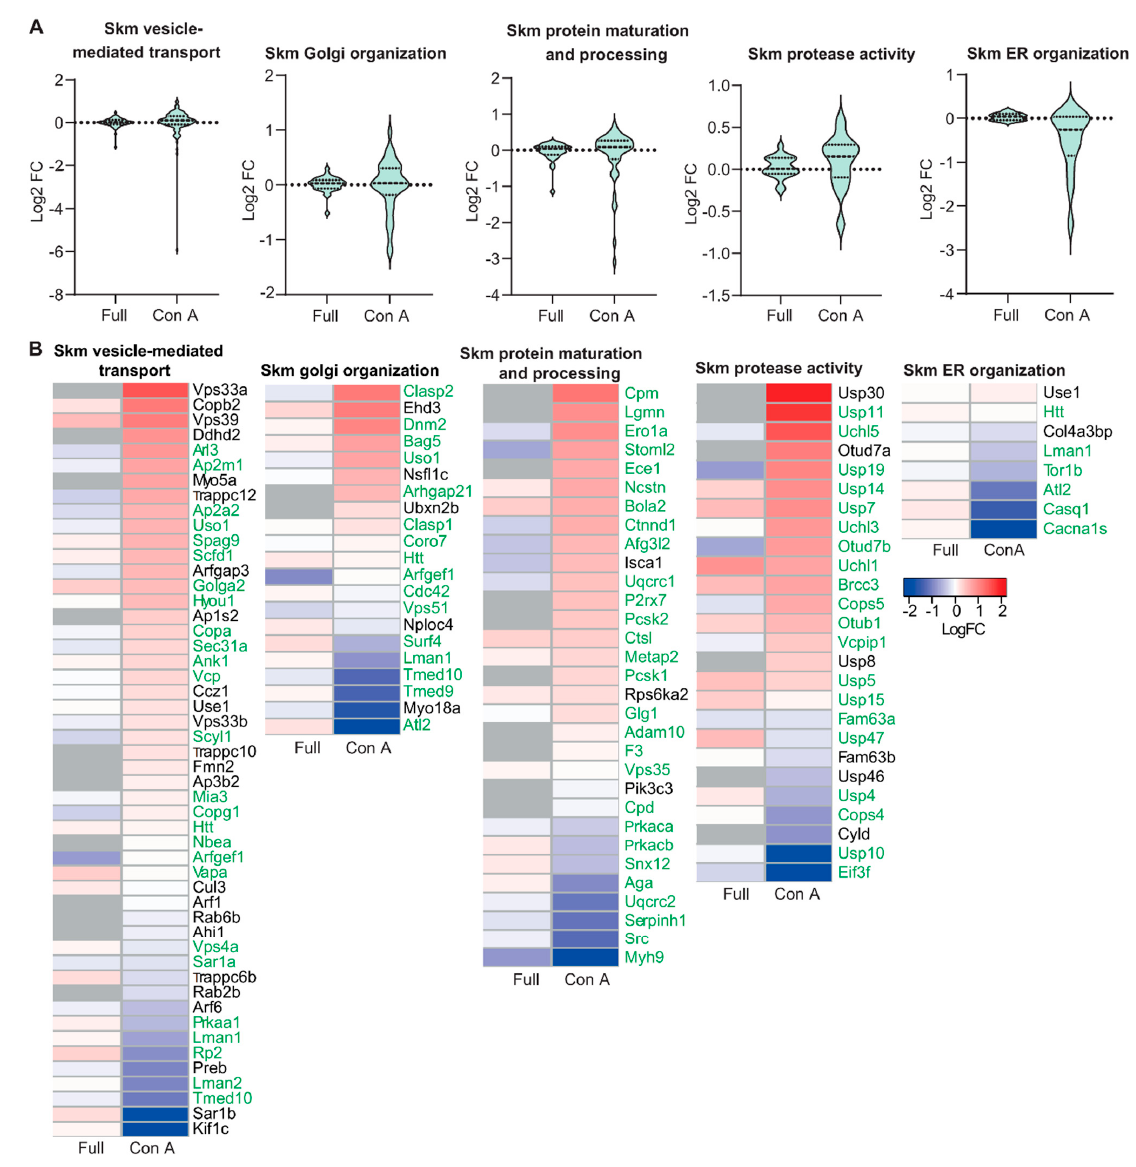
Figure 2. Quantitative changes of proteins necessary for ER and Golgi organization and function in GMPPA KO skeletal muscle compared to WT before and upon Con A pulldown. ( A ) Violin plots for proteins involved in selected biological processes (“Endoplasmic reticulum organization”, “Golgi organization”, “protease activity”, “protein maturation” and “protein processing”, and “vesicle mediated transport”) associated with the ER or the Golgi complex before and upon Con A enrichment (full: whole tissue lysates or Con A: Con A enriched samples). ( B ) Heatmaps for significantly altered proteins in either whole tissue lysates (full) or Con A enriched samples (Con A) (q-value below 0.05). Proteins significantly up-regulated between WT and GMPPA KO are shown in red and those down-regulated in blue (n = 3 mice per group). Not identified proteins are shown in grey. Green labeling indicates glycoproteins.